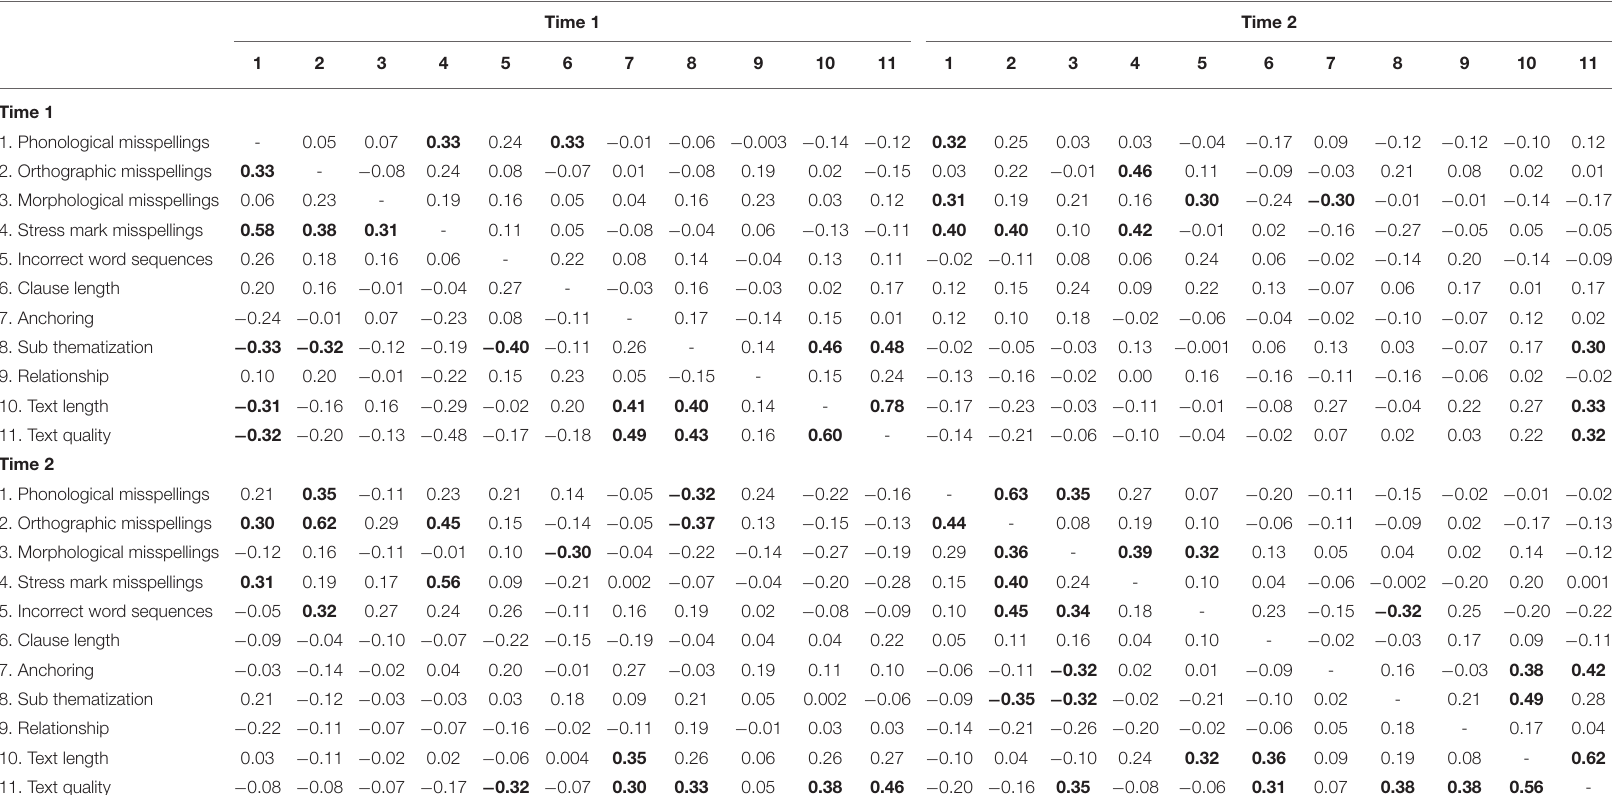
TABLE 2 | Bivariate correlations for all variables at T1 and T2 for the younger cohort (below the diagonal) and the older cohort (above the